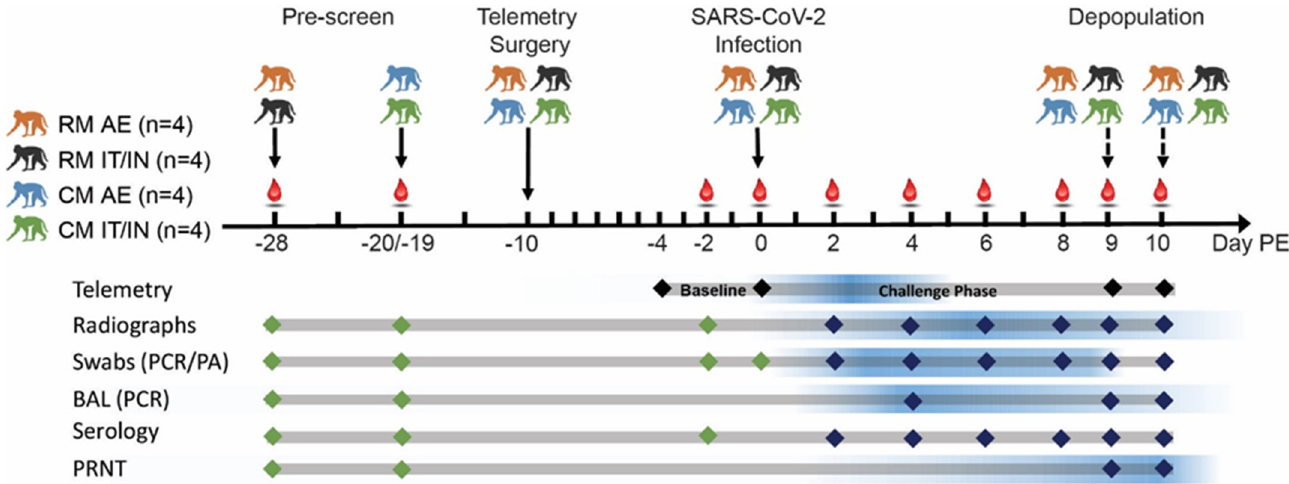
Figure 1. Study design. Red droplets denote phlebotomy days. Baseline sampling points are repre- sented by green diamonds, while dark blue represents post-infection sampling points. The blue gra- dient provides a visual representation of the peak responses observed from each assay/measure- ment.